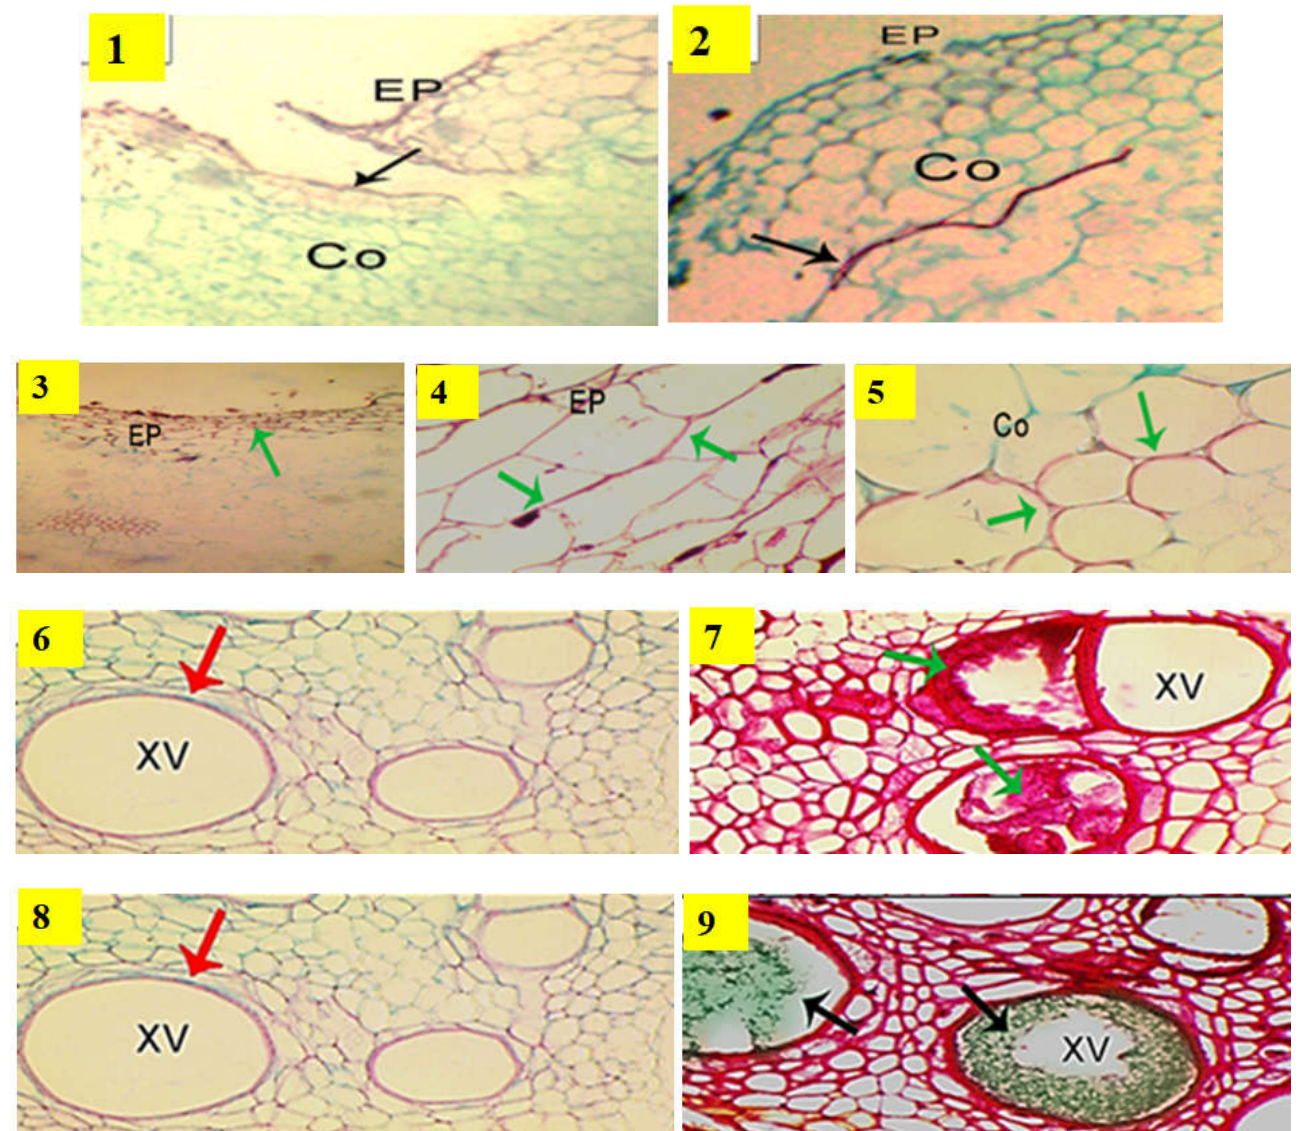
Figure 2. Characteristics of the concrescence of a cucumber grafted union with rootstocks of different compatibilities under disease pressure and heat stress in the most susceptible rootstock, Bottle gourd and the most resistant rootstock, VSS-61 F 1 . Photos 1 and 2 represent the compatibility of grafted union between the rootstock Bottle gourd and the scion; VSS-61 F 1 rootstock and the scion; respectively. Photos 3 and 4 show cell wall lignification (green arrows) at the epidermis (Ep). Photo 5 shows formation of an exodermis (Ex) to prevent penetration of fusarium hypha as well as the lignification of cortical cell walls (Co) (green arrows), which prevent hypha penetration into cortical cells in stem vascular tissues of resistant rootstock VSS-61 F1. Photo 6 shows that accumulation of polyphenol compounds was not detected in xylem vessels (xv) of susceptible rootstock, Bottle gourd; whereas Photo 7 represents accumulation of polyphenols (red staining indicated by green arrowheads) in xylem vessels of resistant rootstock VSS-61 F1. Photo 8 shows that accumulation of carbohydrates was not detected in xylem vessels of susceptible rootstock, Bottle gourd; whereas Photo 9 represents accumulation of carbohydrates (green staining indicated by black arrowheads) in xylem vessels of resistant rootstock VSS-61 F1. Control treatment (non-grafted plant) is not shown here because all control plants died due to the infection by Fusarium wilt.